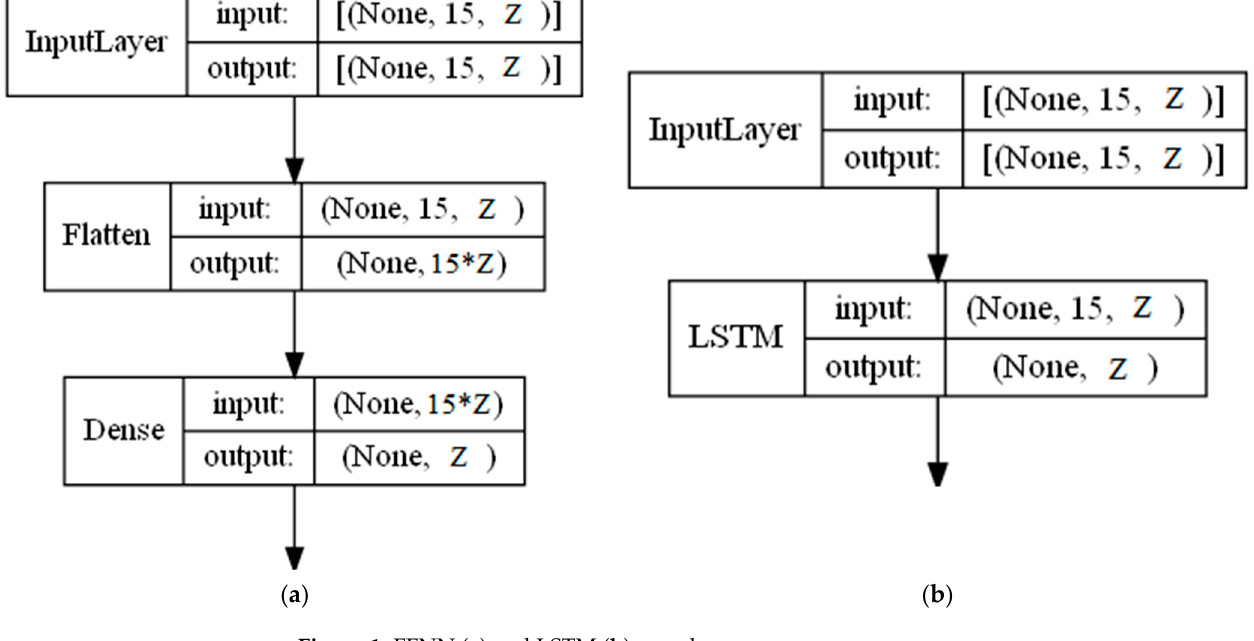
Figure 1. FFNN ( a ) and LSTM ( b ) encoders.